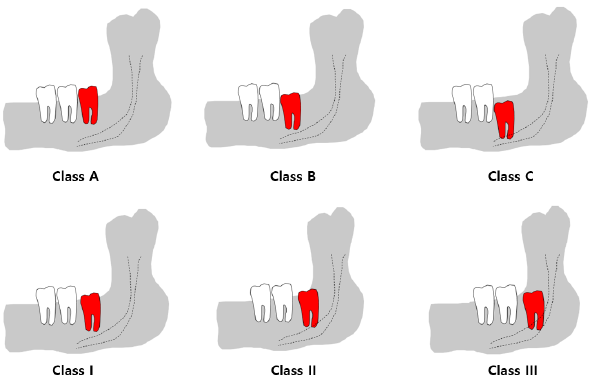
Figure 2. Pell and Gregory classification. The red teeth are the mandibular third molars. In the first row, there are figures regarding the depth of the impacted mandibular third molar, and classes A, B, and C from the left. In the second row, there are figures about the distance between the mandibular third molar and the ascending mandibular ramus, and classes I, II, and III from the